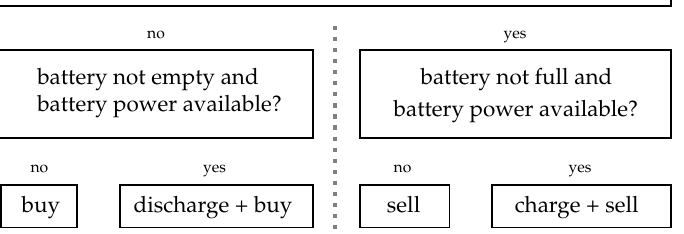
Figure 1. Simplified illustration of heuristic-based energy management strategy by Norbu et al.